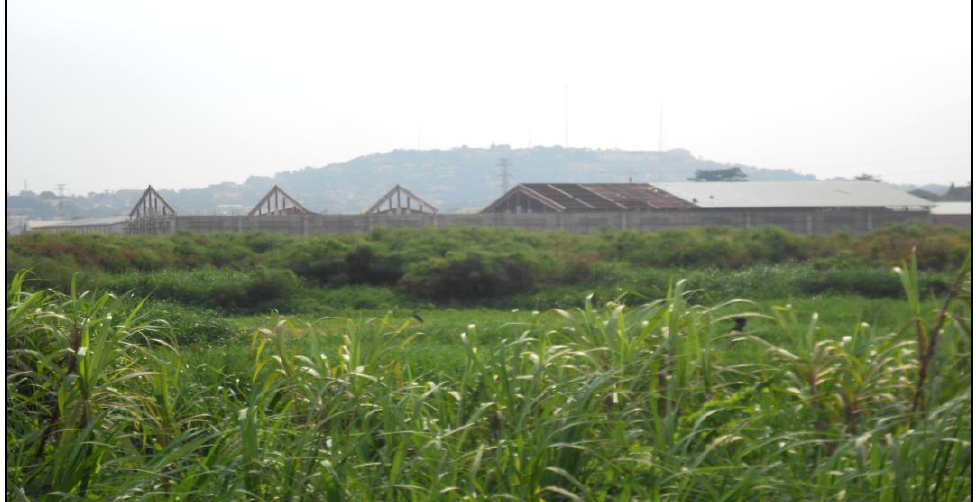
Fig. 5. An industry under construction in a reclaimed wetland near the Capital City – Kampala, in the Central Region, by Alex Barakagira, 2013